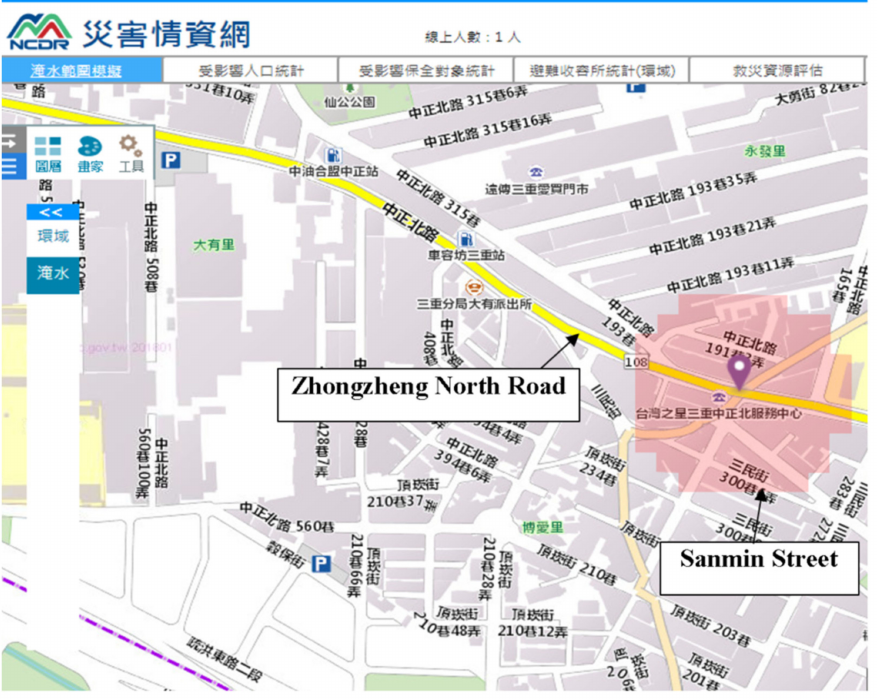
Figure 15. Flooded area in Sanchong District (depicted as a red grid).